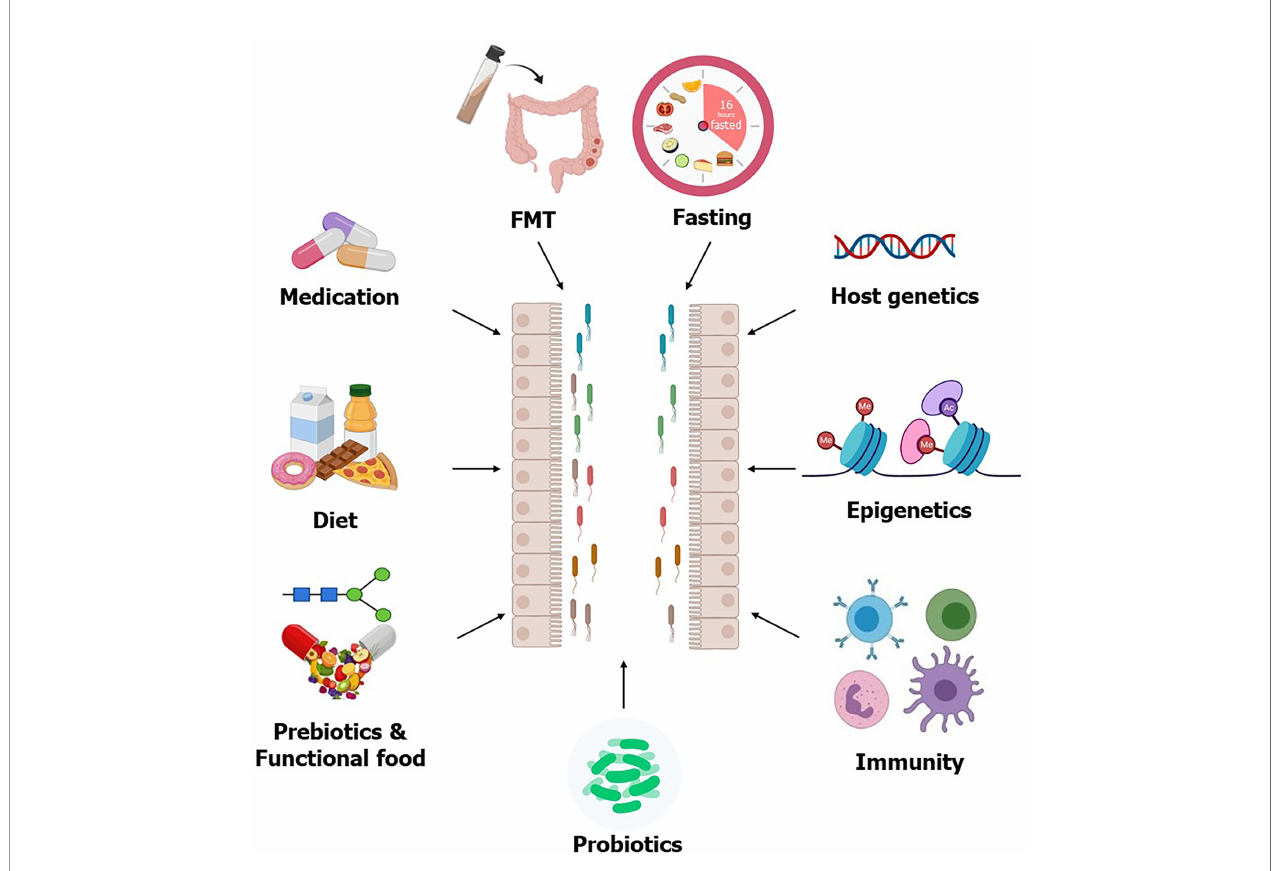
FIGURE 1 | Factors affecting gut microbiota . The gut microbial composition can be modulated by different interventions such as prebiotics, probiotics, FMT, and intermittent fasting, all of which are considering as potential therapeutics for T2D. Host genetics, epigenetics, and immunity also modulate gut microbiota. Some T2D medication improves circulating glucose levels partly through modulating gut microbiota, which further supports the usability of the gut microbiota as therapeutics for